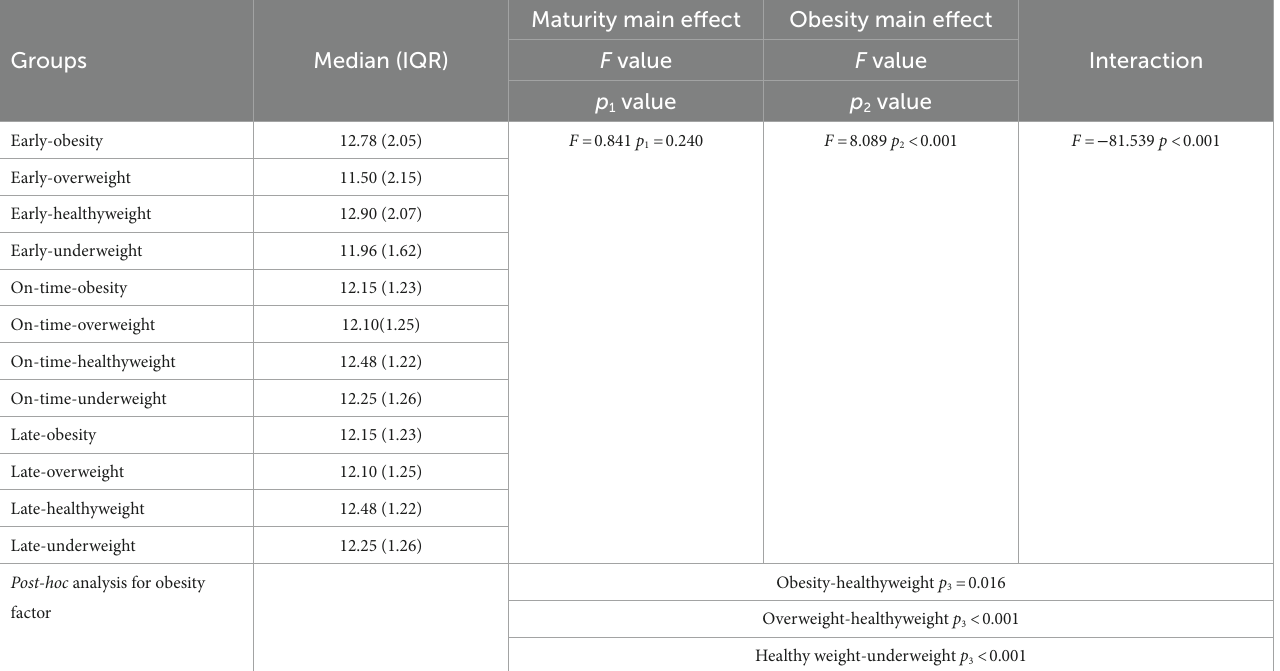
TABLE 1 Changes in the age of the participants according to the maturity and obesity